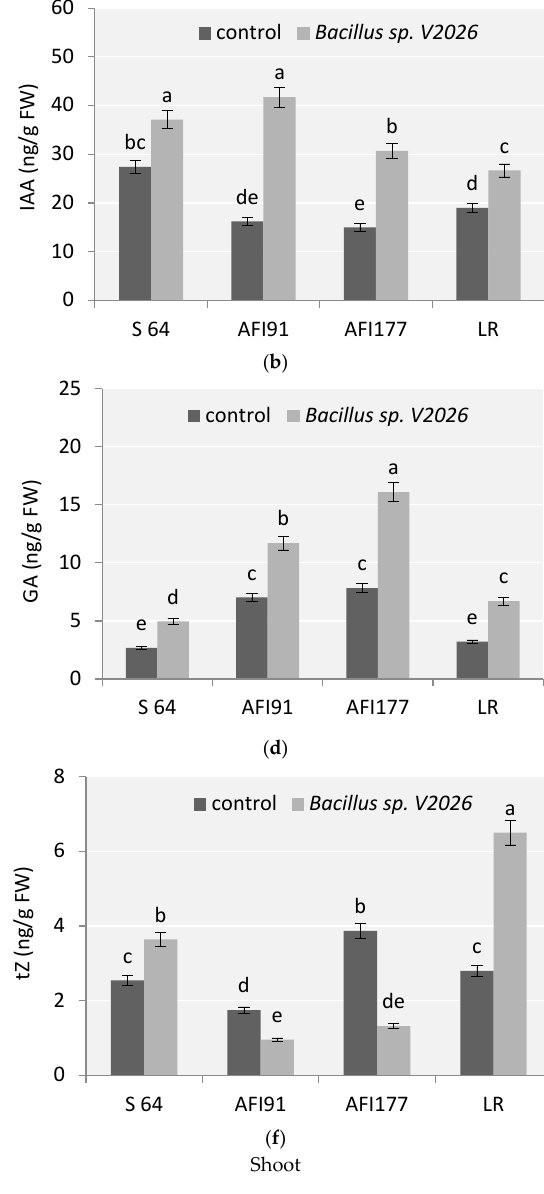
Figure 5. Effect of Bacillus sp. V2026 on concentrations of plant hormones: ( a , b ) indole-3-acetic acid (IAA); ( c , d ) gibberellic acid (GA); and ( e , f ) trans-Zeatin (tZ) in roots ( a , c , e ) and shoots ( b , d , f ) of early-maturing wheat plants grown under hydroponic conditions. Bars with different letters are significantly different at p ≤ 0.05, as determined by Duncan’s multiple range